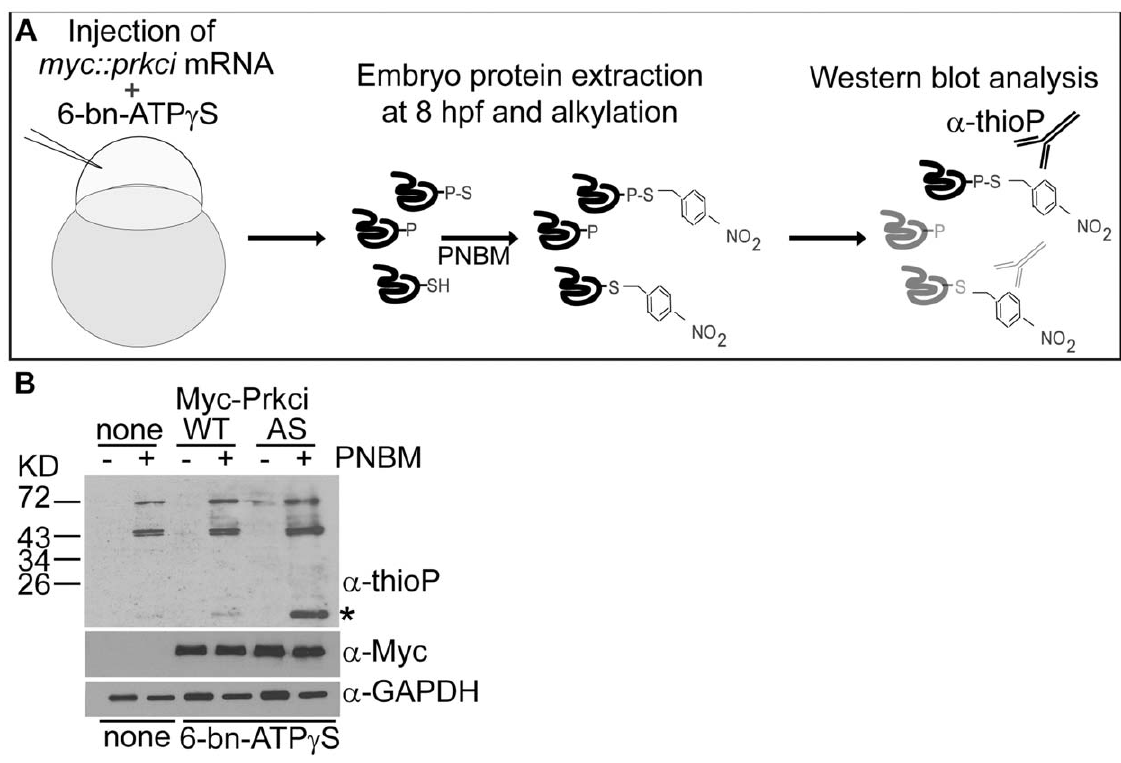
Figure 4. Thiophosphorylation of substrate proteins by Prkci I316 in the zebrafish embryo. ( A ) Schematic diagram of the in vivo labeling method for the selective labeling of Prkci I316A substrates during zebrafish development. ( B ) In vivo thiophosphorylation in zebrafish embryos injected at the one-cell stage with 200 m M N 6 -benzyl-ATP c S (6-bn-ATP c S) and mRNA encoding either Prkci WT or Prkci I316A (AS). Western blot analysis with rabbit monoclonal anti-thiophosphoester ( a -thioP) C51-8 antibody (Epitomics) of 80% epiboly (6–8hpf) samples alkylated with 2.5 mM PNBM reveals a selectively labeled protein in the Prkci I316A (AS) sample (asterisk).